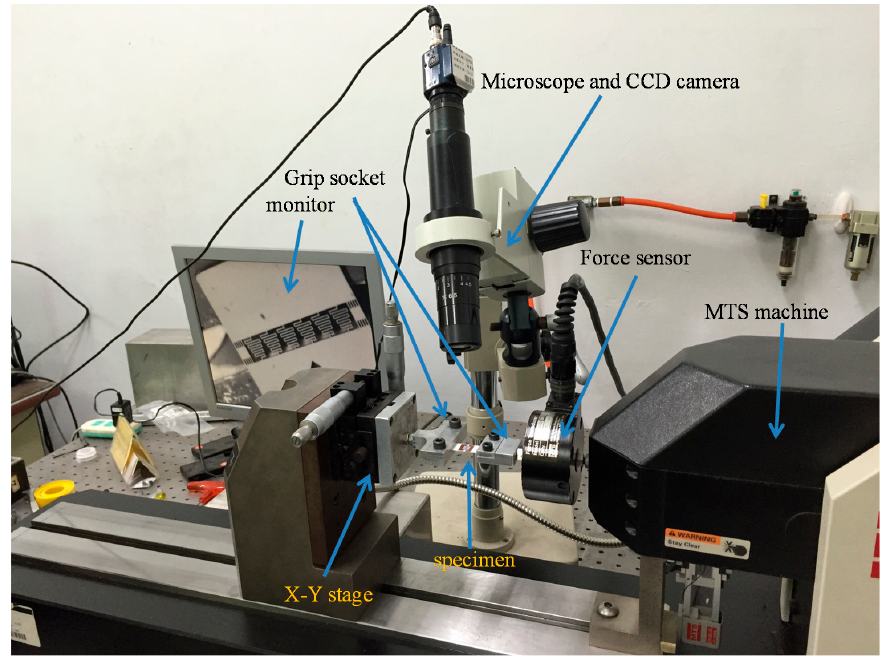
Figure A2. Microtesting system set ‐ up.